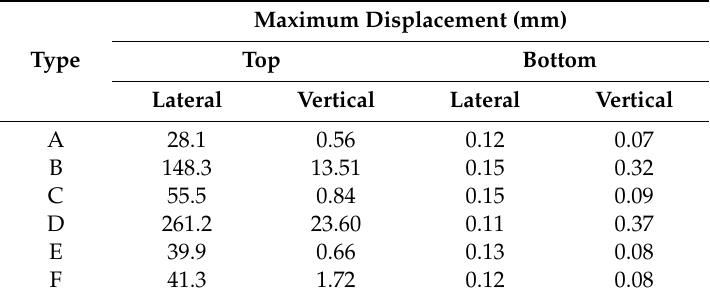
Table 6. Maximum displacement according to